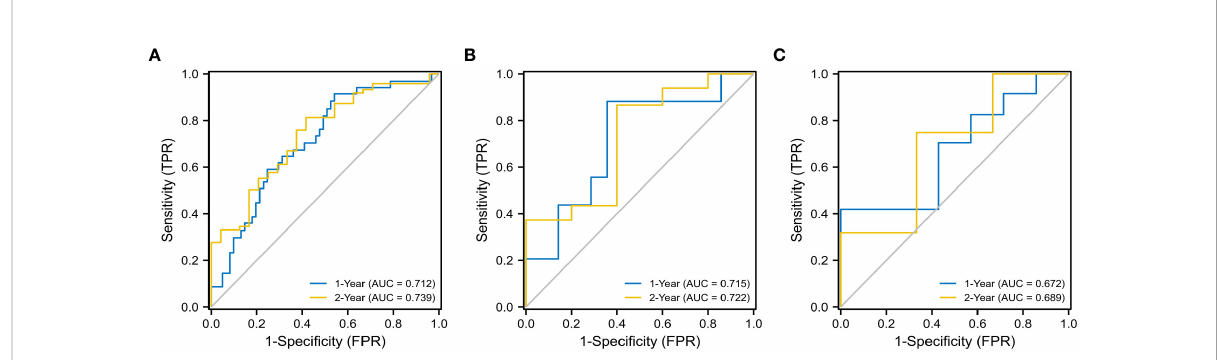
FIGURE 4 ROC analysis for 1- and 2- year OS of the radiomics models. The training cohort (A) (1- year: AUC = 0.712, 2 - year: AUC = 0.739), the internal validation cohort (B) (1- year: AUC = 0.715, 2 - year: AUC = 0.722), and the external validation cohort (C) (1- year: AUC = 0.672, 2 - year: AUC = 0.689).